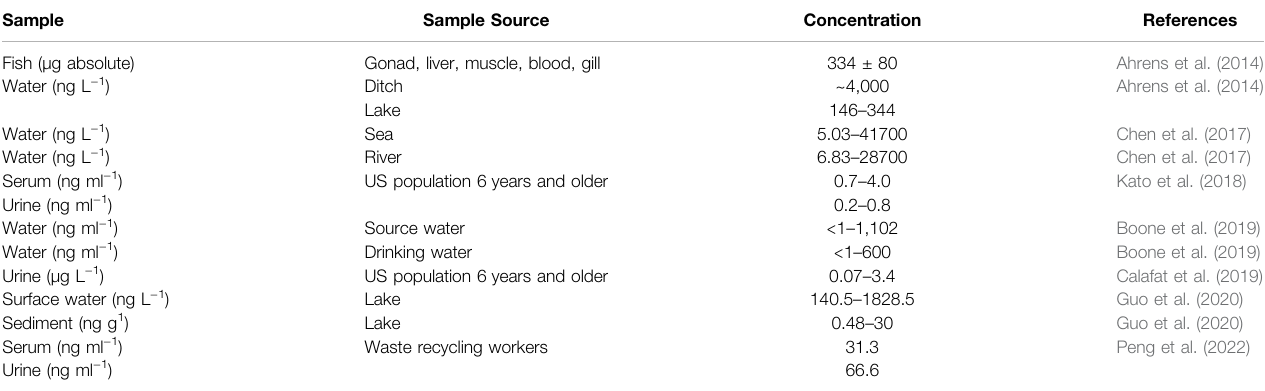
TABLE 1 | Examples of concentrations of PFAS found in the environment due to human activities.